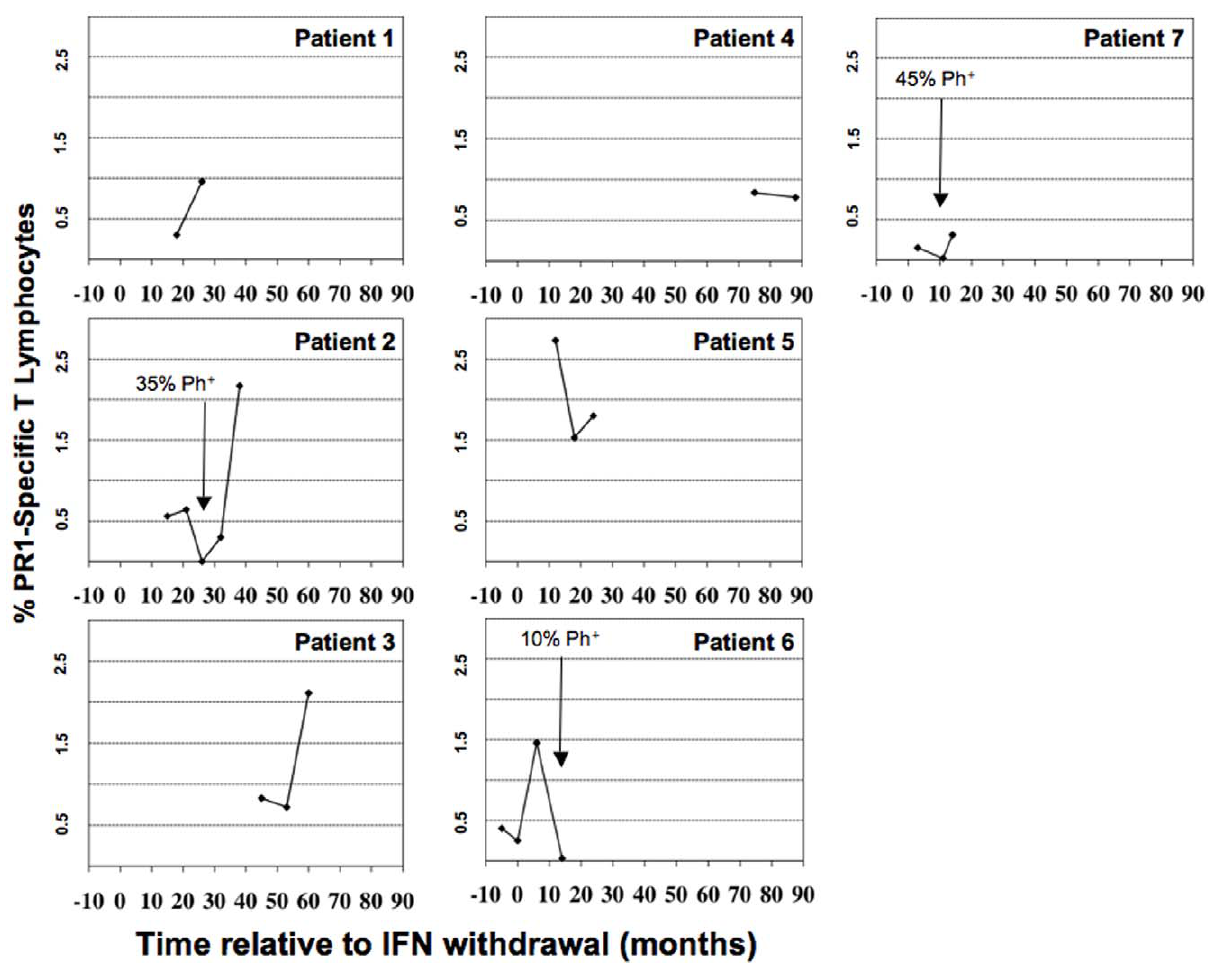
Figure 2. PR1-CTL persist in patients that maintain remission after IFN withdrawal. For each patient, the panel shows the total percentage of CD8 + cells that were identified with the PR1/HLA-A2 tetramer at time points after IFN withdrawal.